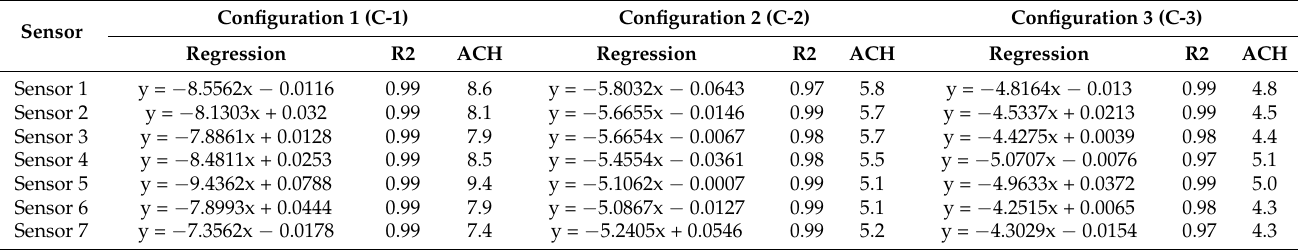
Table A1. Decay curves in Classroom